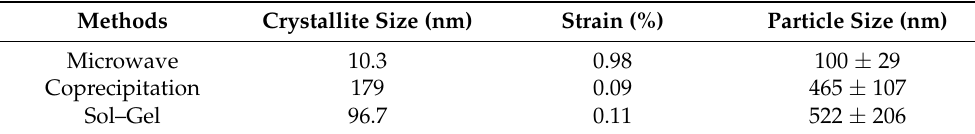
Table 2. Crystallite size, strain, and particle size of HAp synthesized by microwave, coprecipitation, and